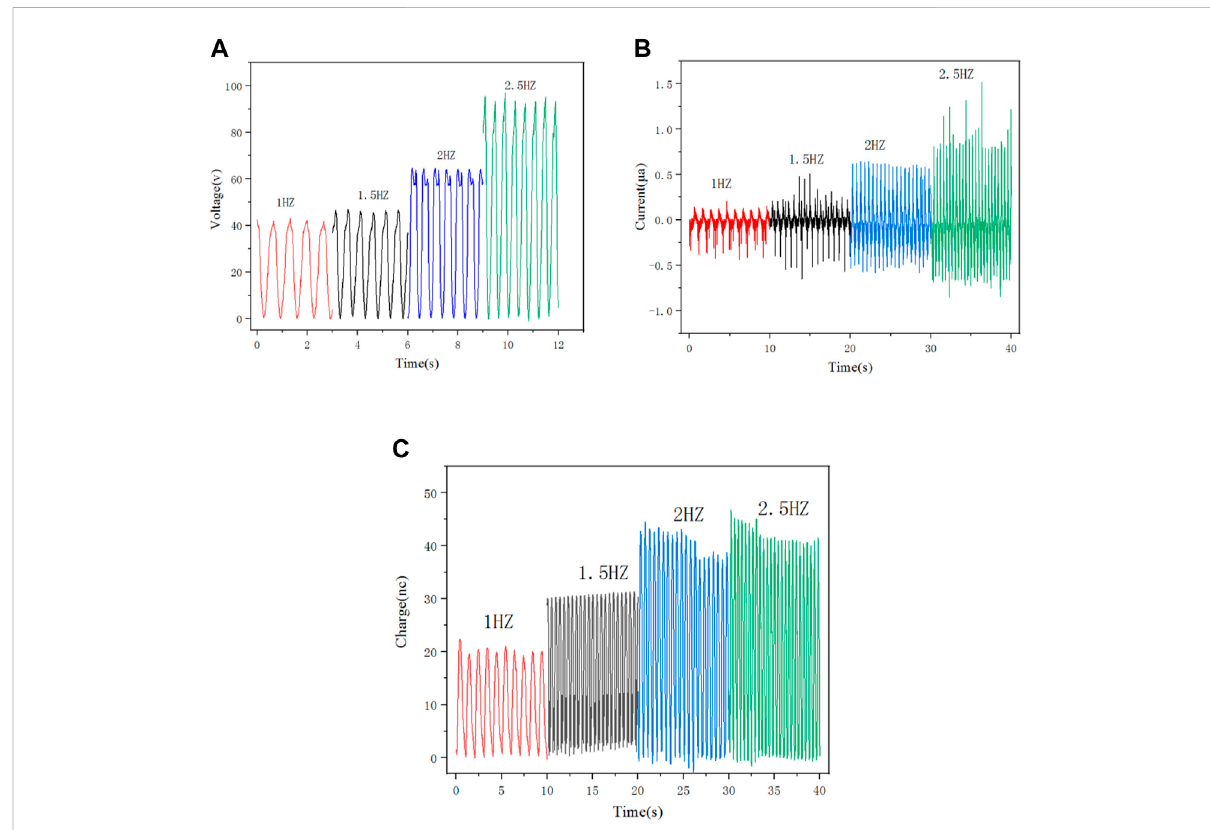
FIGURE 9 Outputperformanceatthesameamplitudeanddifferentfrequencies. (A) Open-circuitvoltage; (B) Short-circuitcurrent; (C)